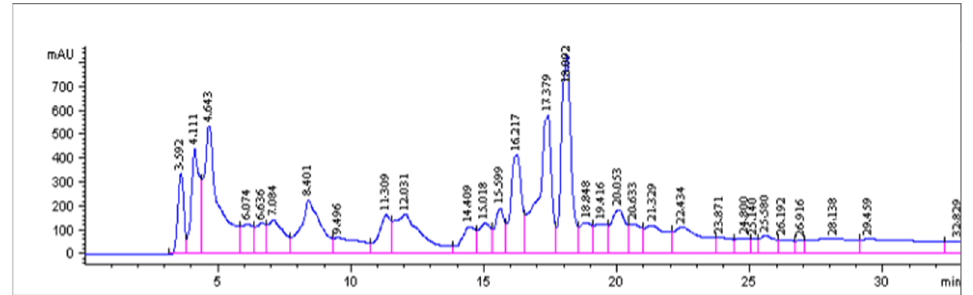
Figure 3. HPLC chromatogram of bioactive fraction after gel exclusion chromatography.